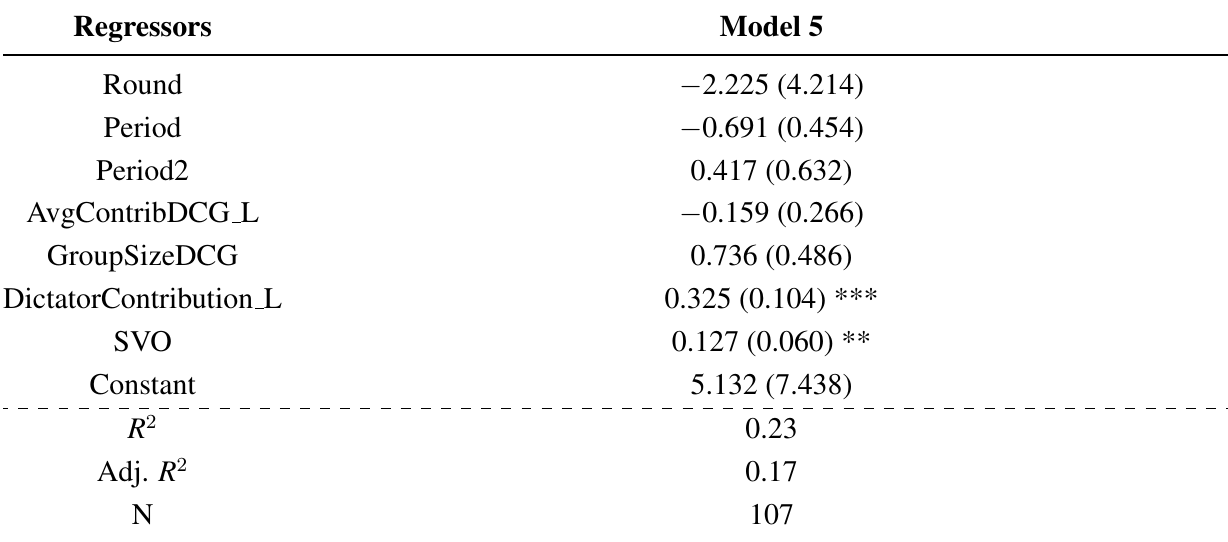
Table 4. Determinants of dictator contribution choice. The table shows the results of an OLS regression of the dictator’s own contribution on a number of regressors. Round is 1 (2) in the first (second) of the two 10-period sequences. Period2 equals the period number Period in round 2 and zero otherwise. SVO is the social value orientation of the dictator, measured using the slider-measure from Murphy et al . [28]. The remaining variables are the lagged average contribution in the DCG, the concurrent DCG group size and the lagged dictator contribution. The inclusion of the lagged variables leads to the exclusion of the observations from period 1 in rounds 1 and 2. Tobit regression censored at zero and 20 yields similar results. Robustness checks, where we include various questionnaire response items and interaction terms, yield no clear effects from the control variables, but leave the main effects